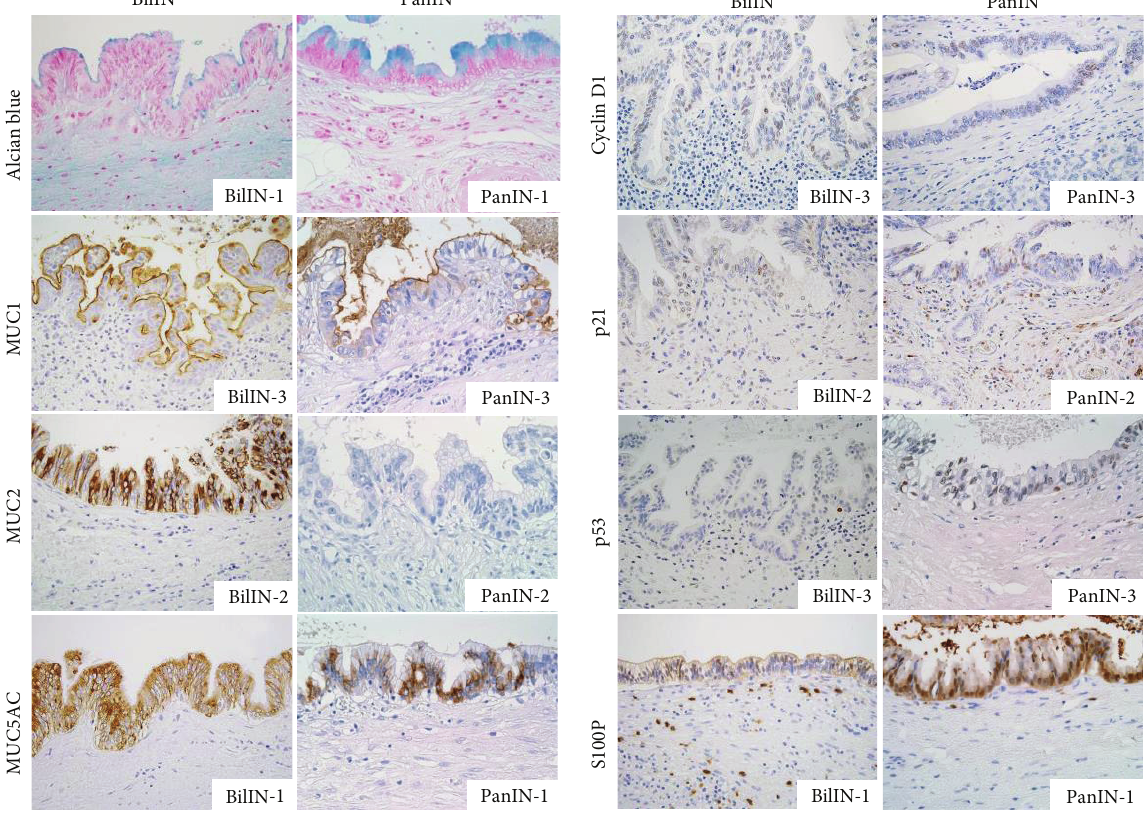
Figure 2: Representative images of histochemical and immunohistochemical staining. The results of mucin staining with Alcian blue (pH 2.5) and immunostaining of MUC1, MUC2, MUC5AC, cyclin D1, p21, p53, and S100P for biliary intraepithelial neoplasia (BilIN) and pancreatic intraepithelial neoplasia (PanIN) are shown. Original magnifications, ×